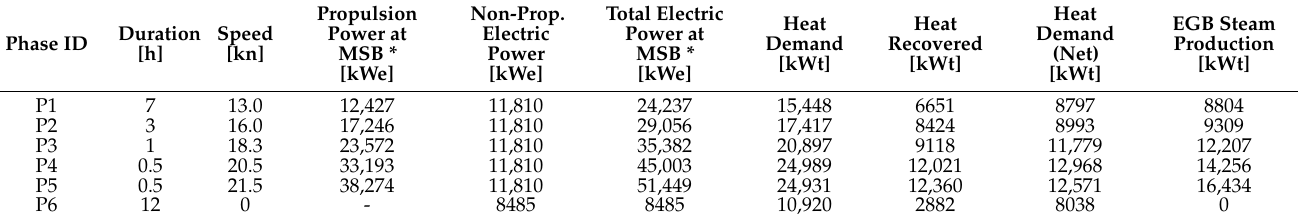
Table 4. Gross electrical and thermal balances of the cruise ship for a typical daily operating profile.